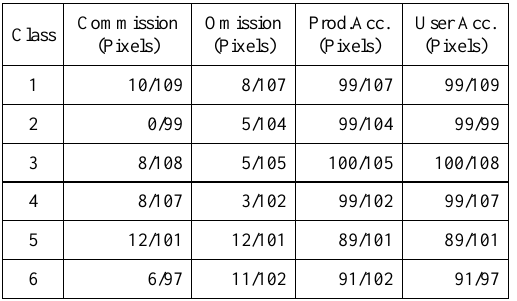
Table 6. Example of Confusion matrix for 30.01.2010 image From the confusion matrix, some observations about the errors that affect the classification come out.